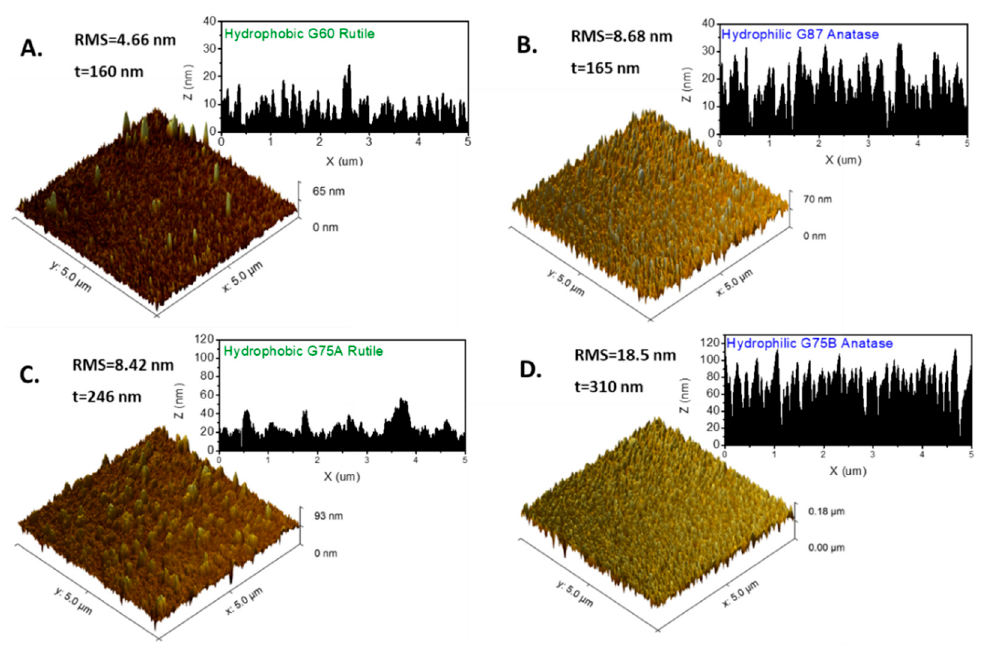
Figure 8. 3D views of the AFM images (5 µ m × 5 µ m) and line height profiles acquired for two hydrophobic and two hydrophilic TiO 2 thins films. ( A , C ): G60 and G75A (hydrophobic rutile), ( B , D ): G87 and G75B (hydrophilic anatase)